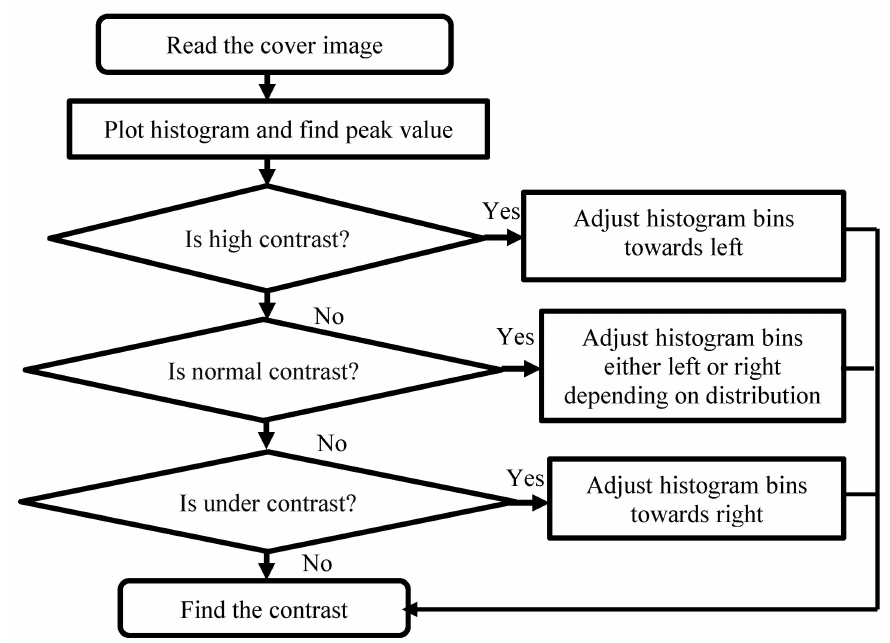
Figure 4. Flow chart for determining contrast and